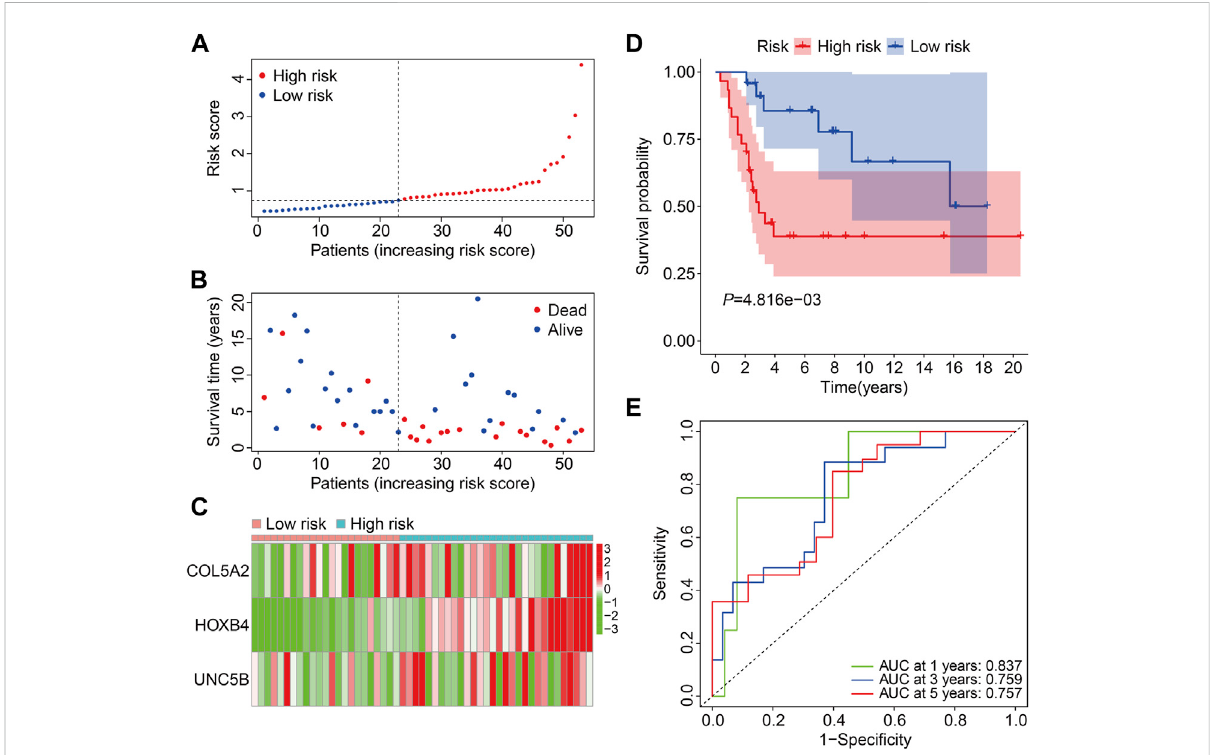
FIGURE 5 Validation of the three-gene-based prognostic signature in external GSE21257 cohorts. (A) Patients ’ risk score distribution in the GSE21257 cohort. (B) Patients ’ vital status and survival time distribution in the GSE21257 cohort. (C) Expression pro fi les of the three FAGs in diverse risk groups of the GSE21257 cohort. (D) Kaplan – Meier survival analysis comparing overall survival between risk groups in the GSE21257 cohort. (E) Time-dependent ROC curves for 2-, 3-, and 5-year survival prediction in the GSE21257